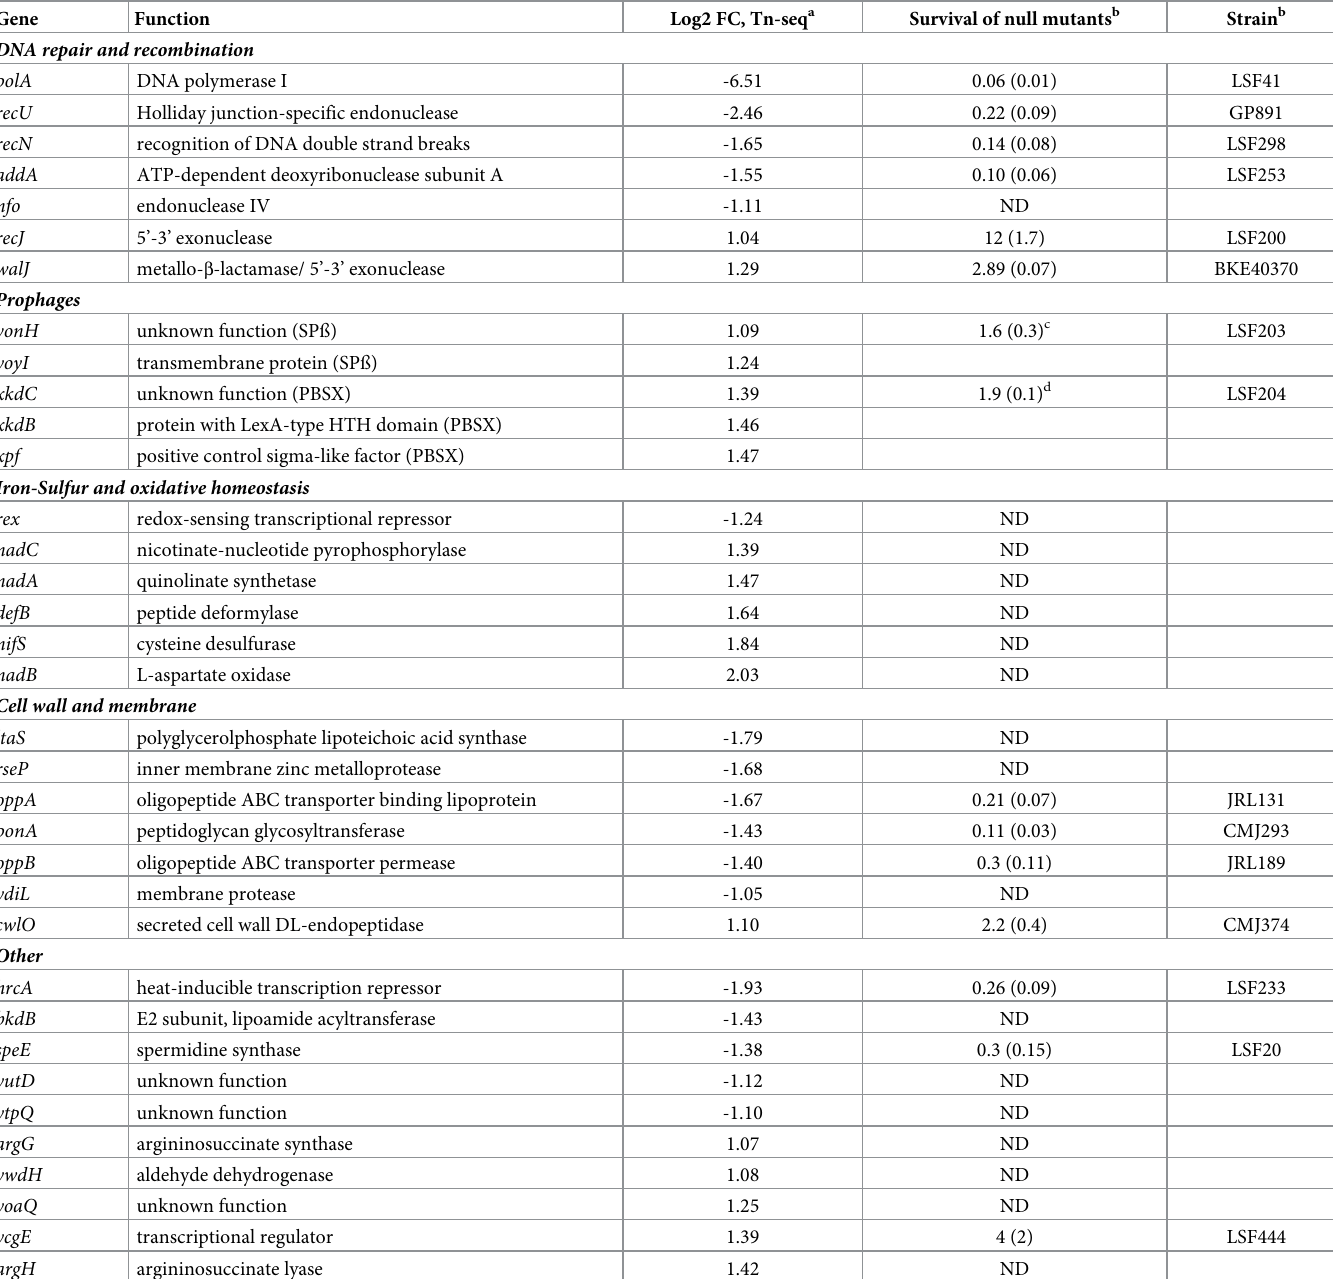
Table 1. Genes identified in Tn-seq analysis of cells surviving replication arrest in the absence of DNA